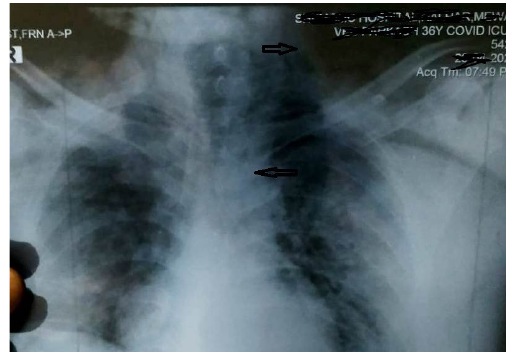
Figure 2. X-ray chest showing bilateral chest infiltrates consistent with COVID-19 pneumonia and presence of SE and PM (the black